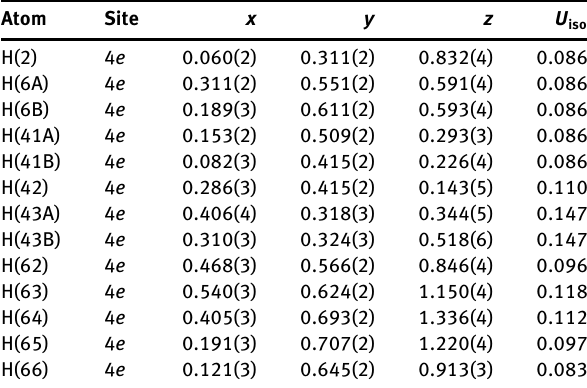
Table 2: Fractional atomic coordinates and isotropic or equivalent isotropic displacement parameters (Å 2